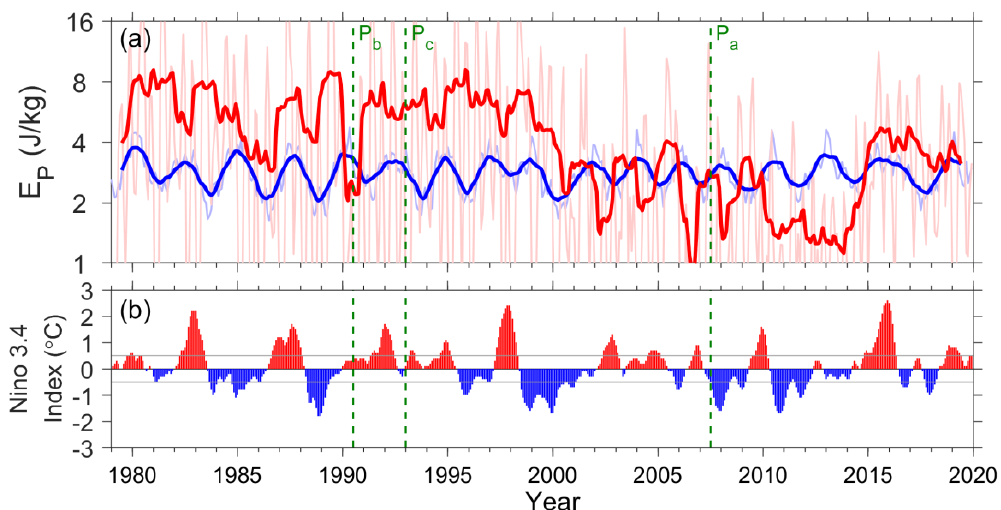
Figure 10. ( a ) The light blue and light red curves plot the monthly zonal mean E P averaged in the lower stratosphere (at 20 – 35 km altitude) and lower mesosphere (60 – 75 km altitude). The bold blue and bold red curves plot the 12-month smoothed values of the light ones, i.e., the 12-month smoothed zonal mean E P , E P–12 , in the lower stratosphere and lower mesosphere, respectively. ( b ) The Niño 3.4 index. The plot uses the same style as that in Figure 3. The dashed green lines indicate the three epochs that were tested using correlation analysis in Figure 11.